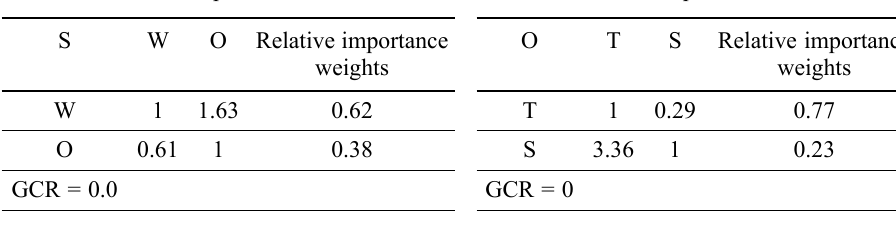
Table 7. The inner dependence